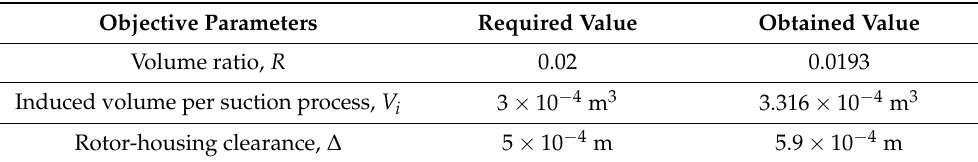
Figure 5. Result of the first stage: ( a ) distribution of 𝐸 𝑜1 ; and distribution of first stage design variables: ( b ) half chord length; ( c ) aspect ratio; ( d ) rotor clearance. Table 4. Comparison of obtained result and required